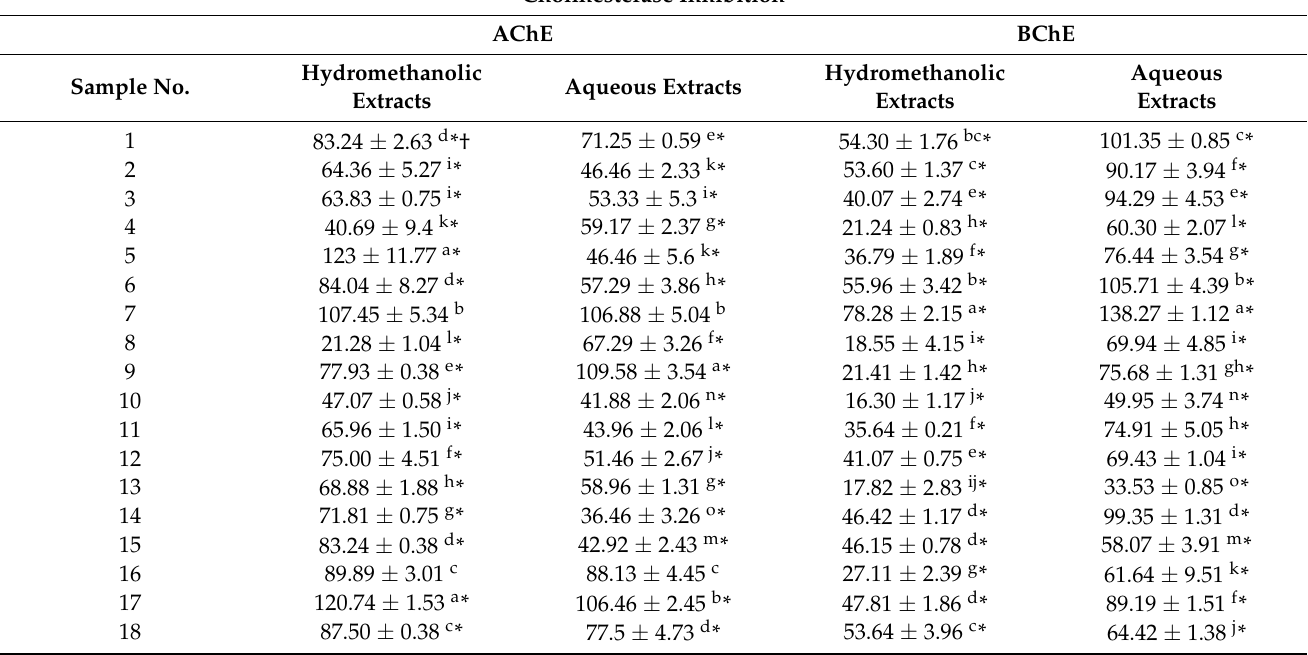
Table 6. Acetylcholinesterase (AChE) and butyrylcholinesterase (BChE) activity (%) compared to control samples (without extract) of hydromethanolic and aqueous extracts of W. somnifera commer- cial